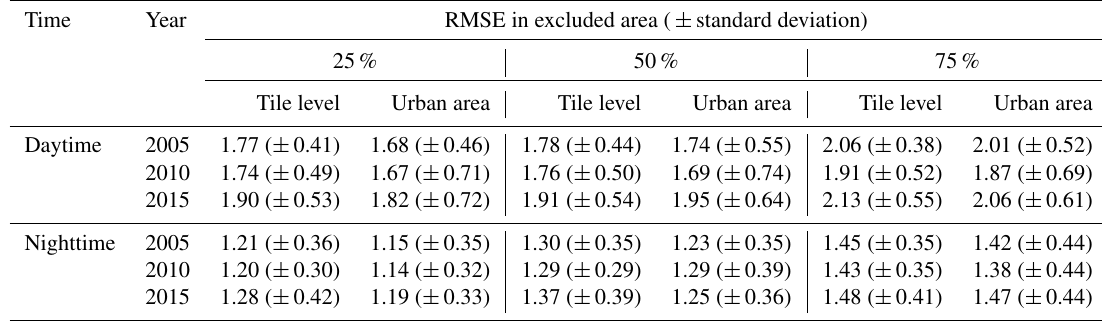
Table 1. Average RMSEs of 15 tiles used in cross-validation analysis of the efficacy of the gap-filling method (unit: ◦ C).